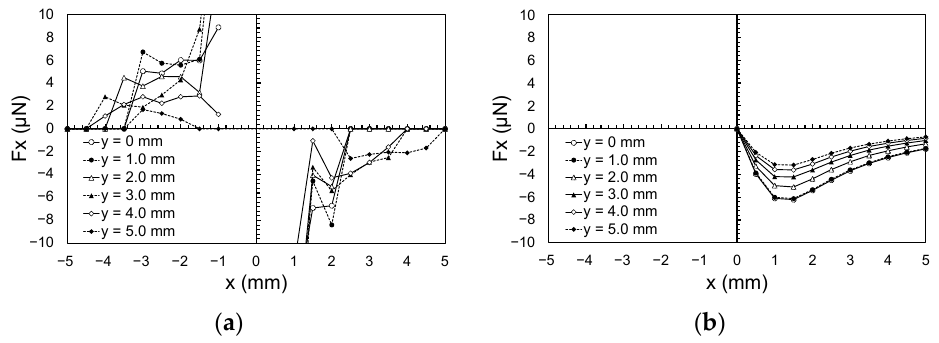
Figure 9. Comparison between the experimental and the numerical simulation on x-component of the electrostatic forces: ( a ) Experimental (four times magnified version of Figure 7); ( b )